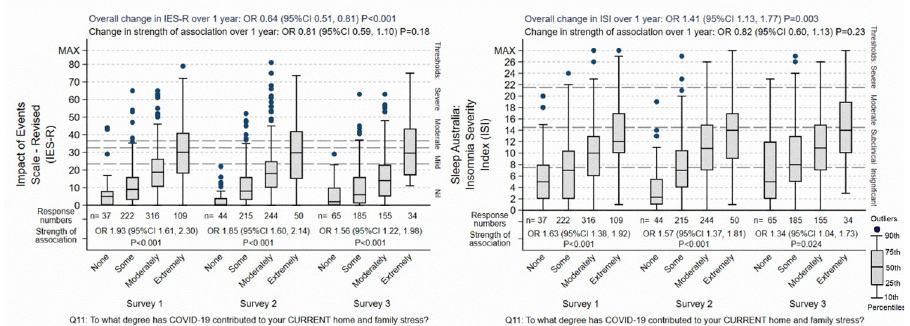
Fig 3. Effect of home / family stress on IES-R and ISI. The “Overall change over 1 year” is the background outcome scale O.R. for change in the respondents not explained by the predictor variable included in the regression models. The “Change in strength of association” is the O.R. for the change of the association of the specific predictor shown in the graph over 1 year, adjusted for the other predictors in the regression models. The box-plots display the group score distributions without adjustment for other predictors. The number of specific responses to the questions are shown at each response and survey period. The “Strength of association” is the association of between the outcome and predictor at each survey period.